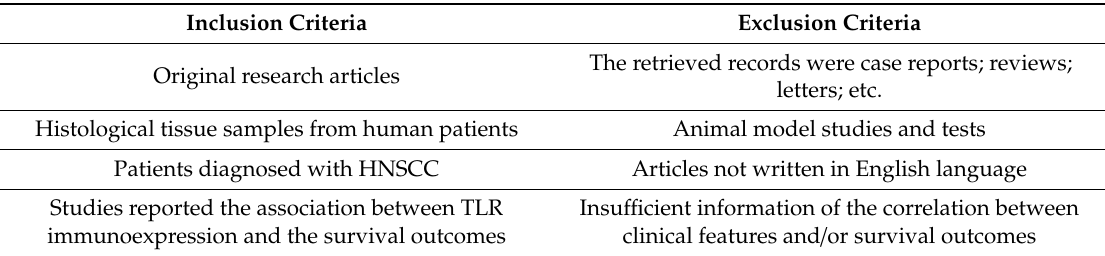
Table 5. Inclusion and exclusion